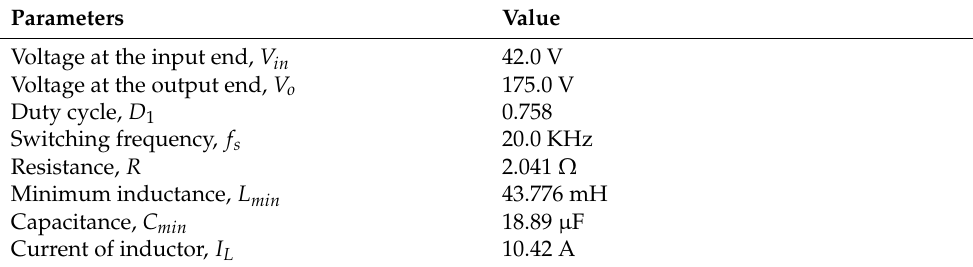
Table 3. Specifications of the first stage.